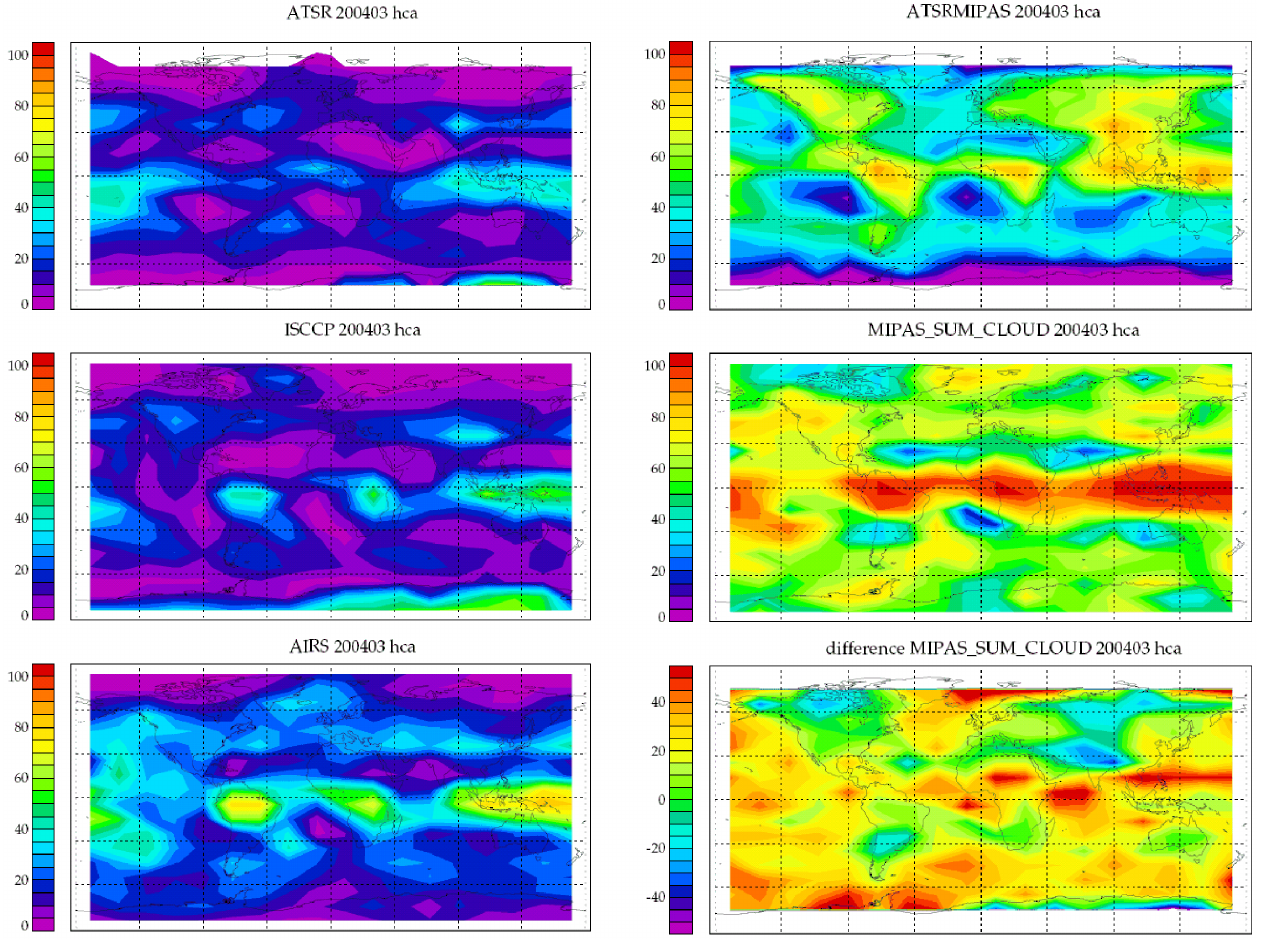
Fig. 19. Comparison of ATSR, ISCCP, AIRS (left column), as well as the MIPAS-like ATSR product (details see text), MIPAS COF of the summary information SUM CLOUD, and the difference between MIPAS and MIPAS-like ATSR (right column) for high cloud amounts (hca: p < 440hPa) for March